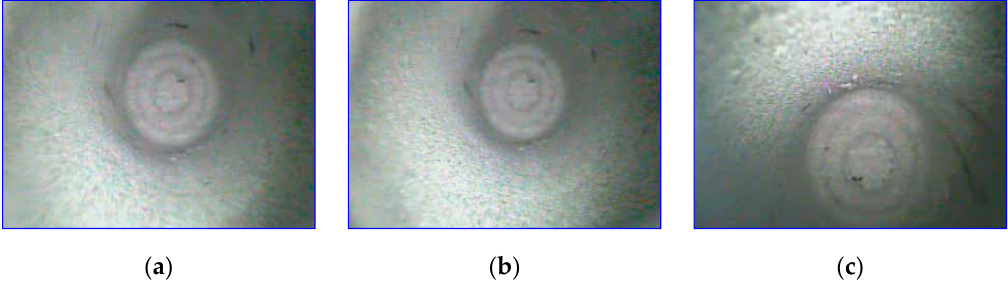
Figure 15. Images of the overburden at #4 characteristic point: ( a ) 100 m from the coalface; ( b ) 30 m from the coalface; ( c ) 20 m from the coalface.